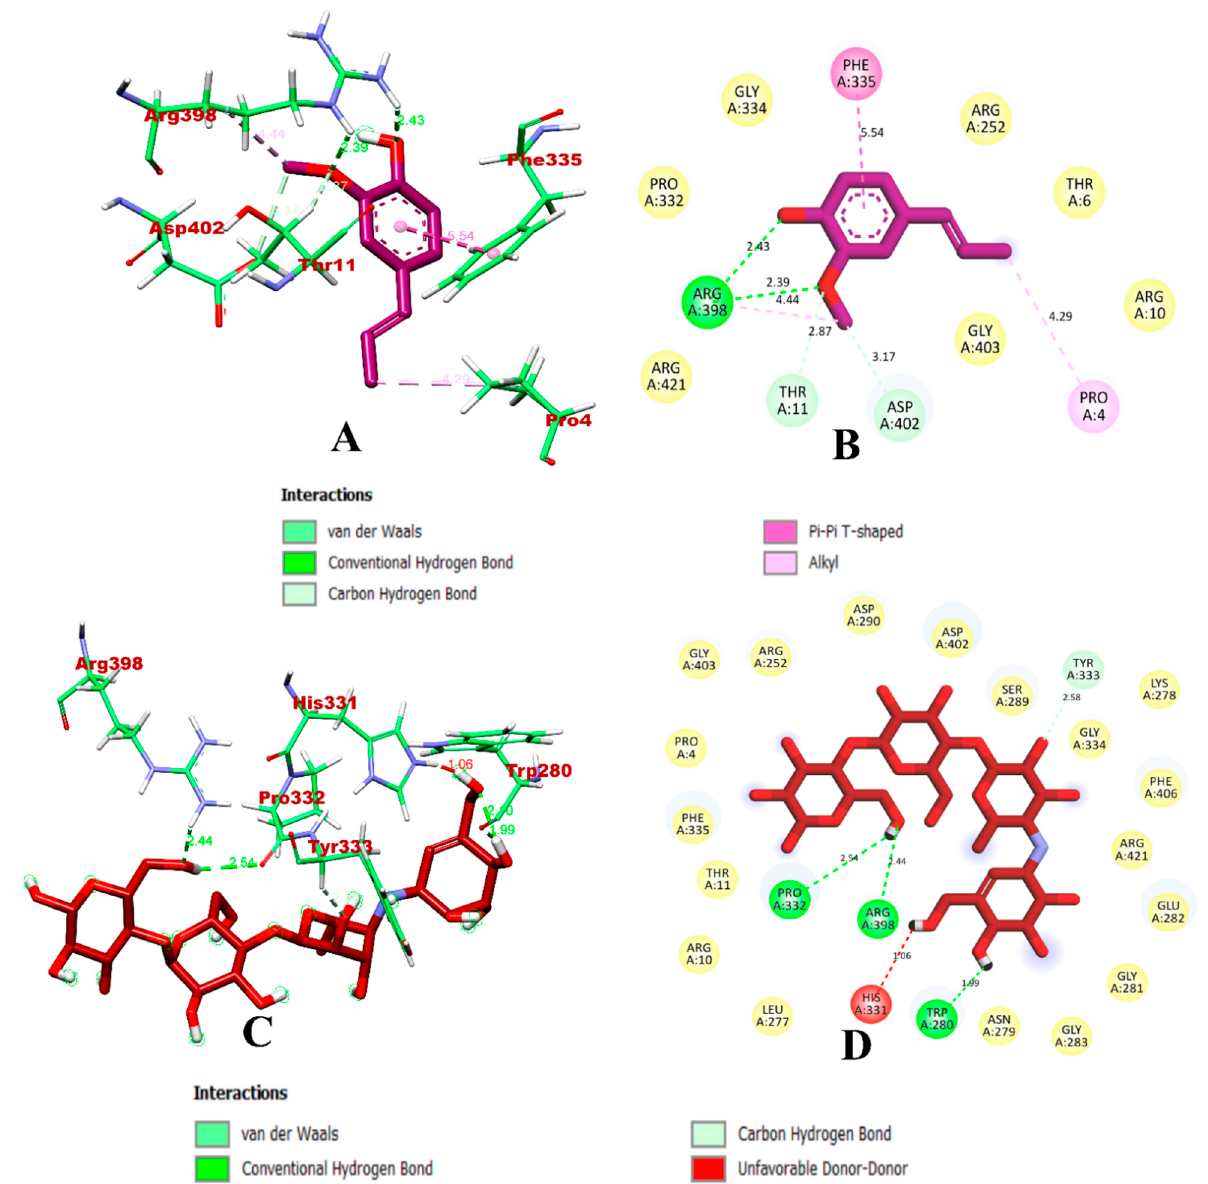
Figure 2. Visualization of the docking simulation of compounds with α -amylase. ( A , B ) Interaction of isoeugenol (purple) visualized in 3D and 2D, respectively. ( C , D ) Interaction of acarbose (red) visualized in 3D and 2D, respectively.